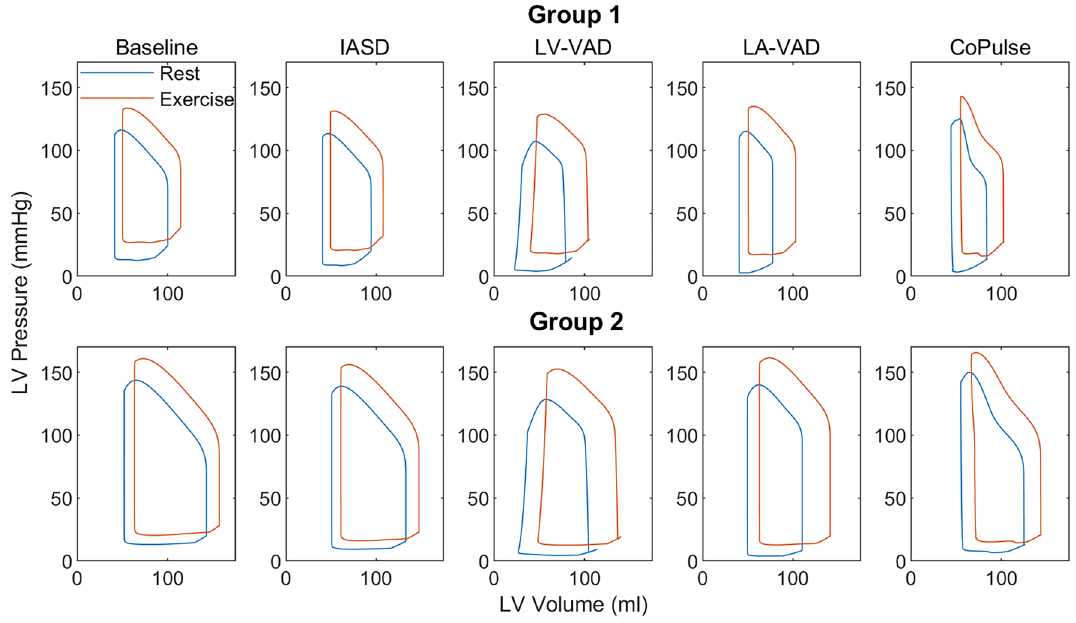
Figure 5. Pressure–volume loops at rest (blue) and exercise (red) for Group 1 (upper panels) and Group 2 (lower panels) visualizing the different working principles of the four different device-based treatment options and their effect on cardiac mechanics.